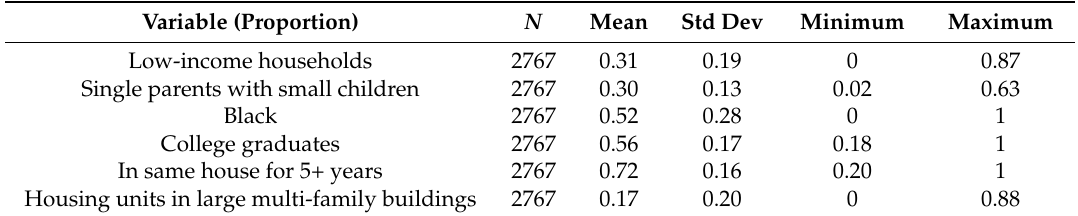
Table 4. Social environment characteristics of children’s home